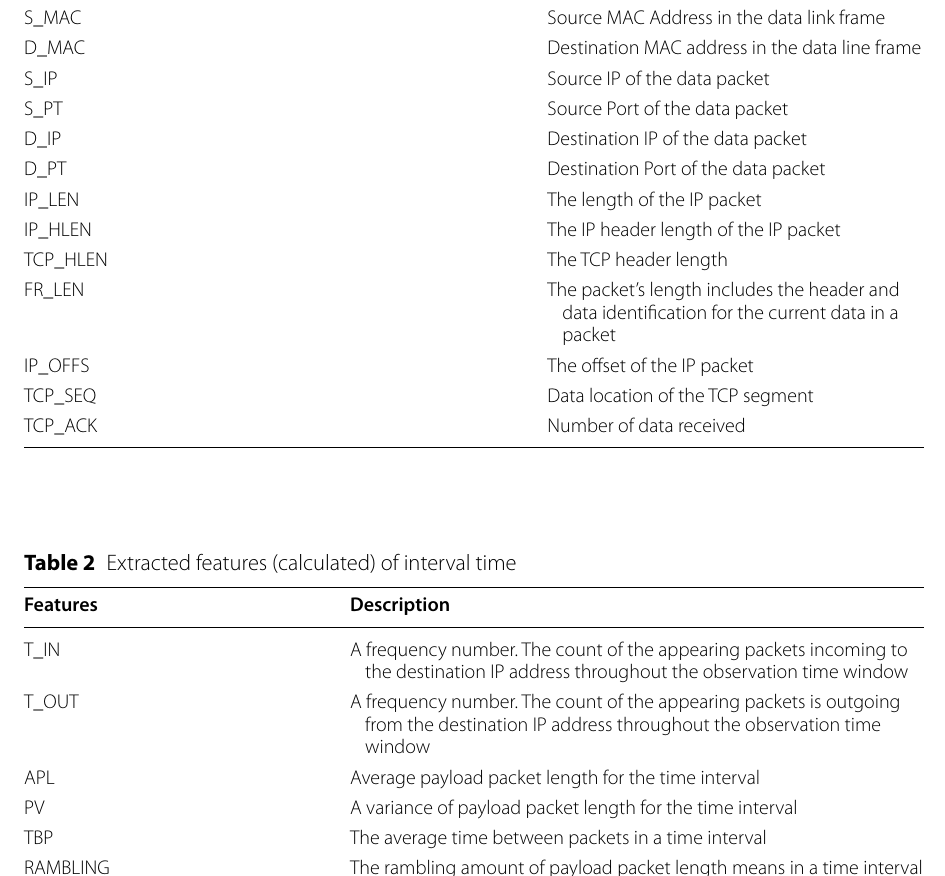
Table 1 The feature extracted from network traffic Features